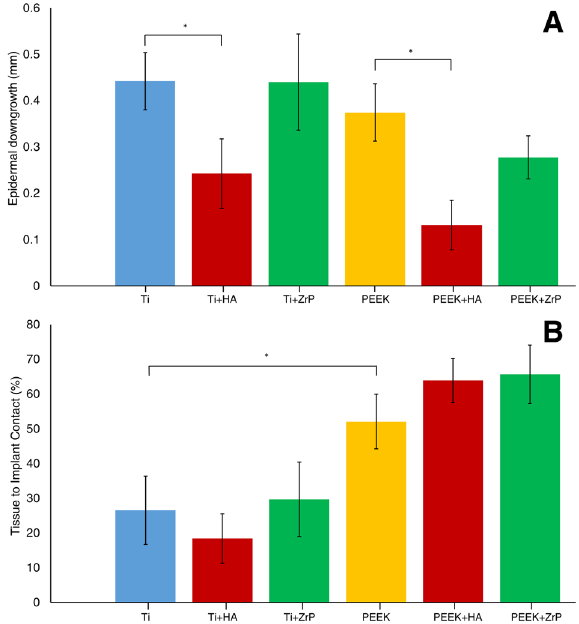
Fig. 15 Results from the histomorphometry on the Ti and PEEK samples, A Epidermal Downgrowth (ED), B Tissue to Implant Contact (TIC). Error bars show Standard